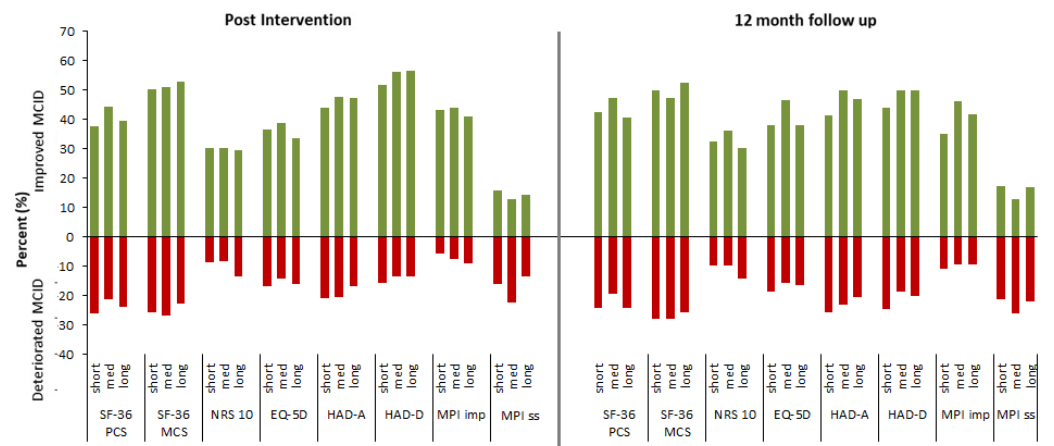
Figure 3. Figure illustrates minimal clinically important di ff erence (MCID) for primary and secondary outcomes at post-intervention and 12-month follow up. Positive bars (green) show proportion of patients that improved while negative (red) shows proportion of patients that deteriorated.